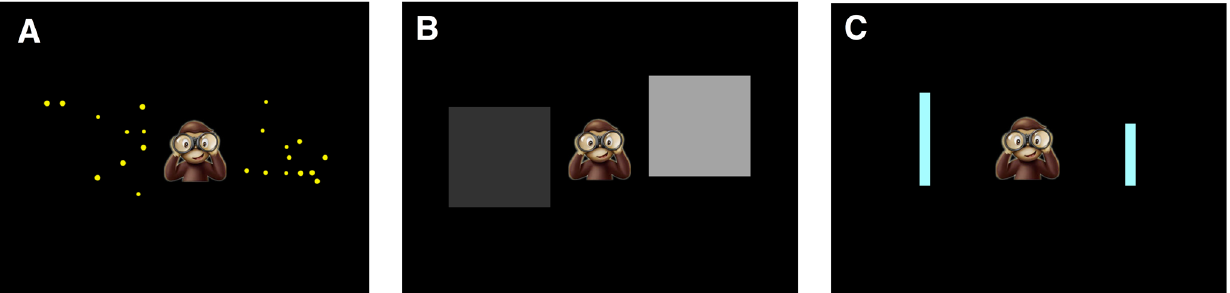
Figure 1. Example stimuli for the nonsymbolic number task (A), luminance task (B), and line length task (C).